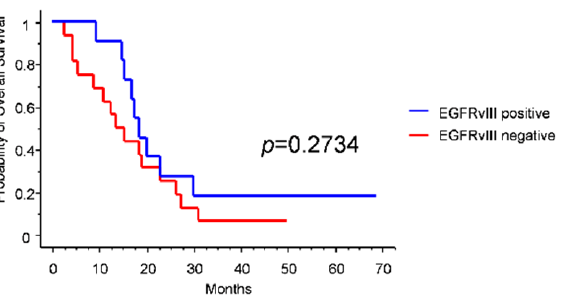
Figure 3. Kaplan–Meier survival curves for EGFRvIII expression in the trial-like subgroup.